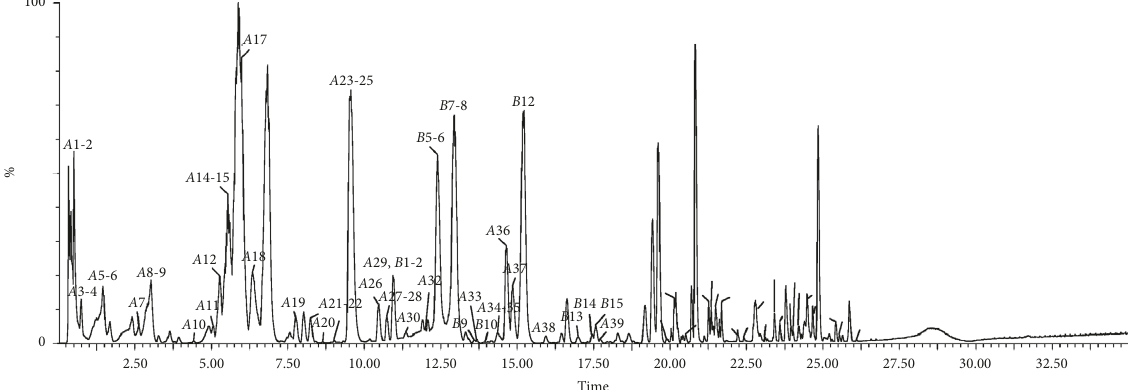
Figure 4: LC-MS chromatograms of extracts from MD in negative-ion mode.